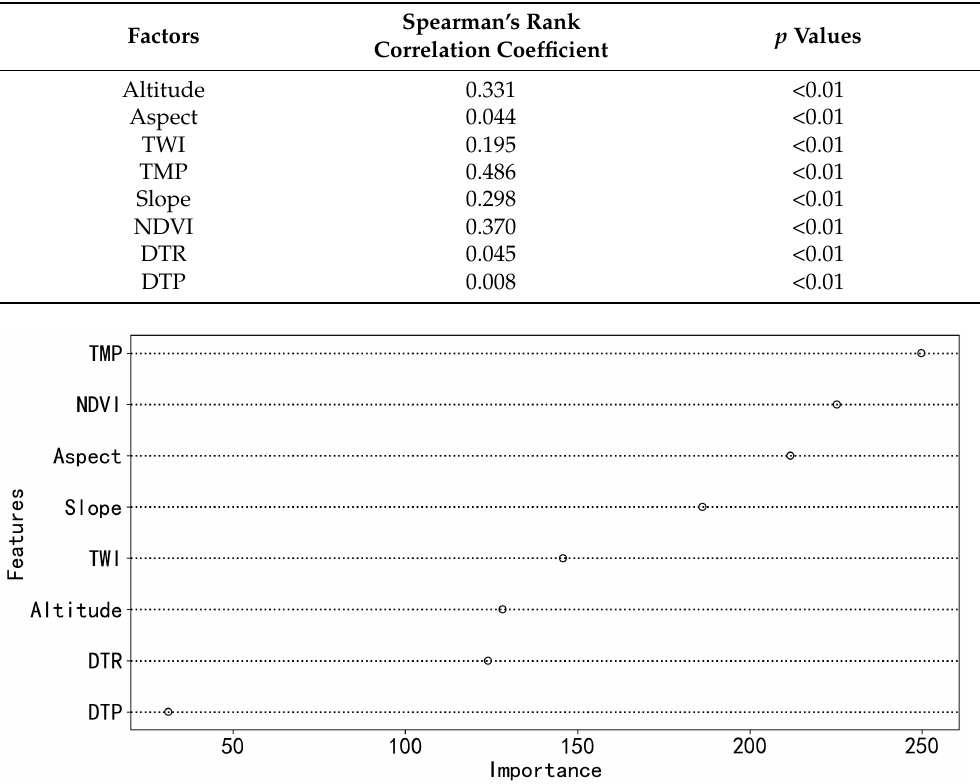
Table 2. The relationship between the independent variables and dependent variables.